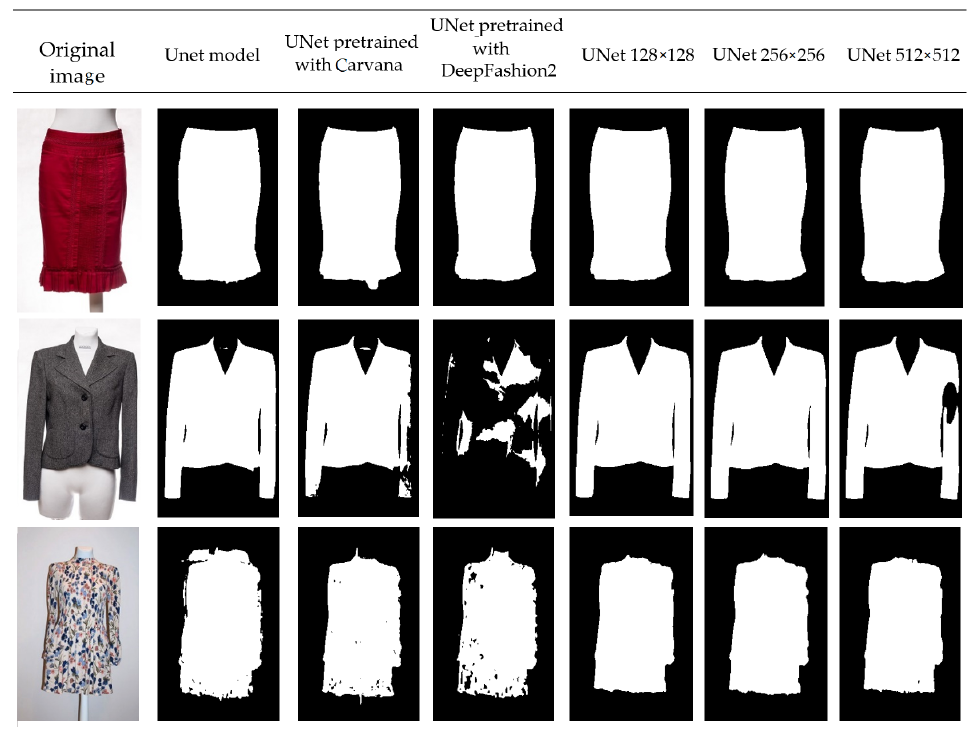
Figure 4. Different Unet models’ segmentation results for selected clothes: skirt, jacket and